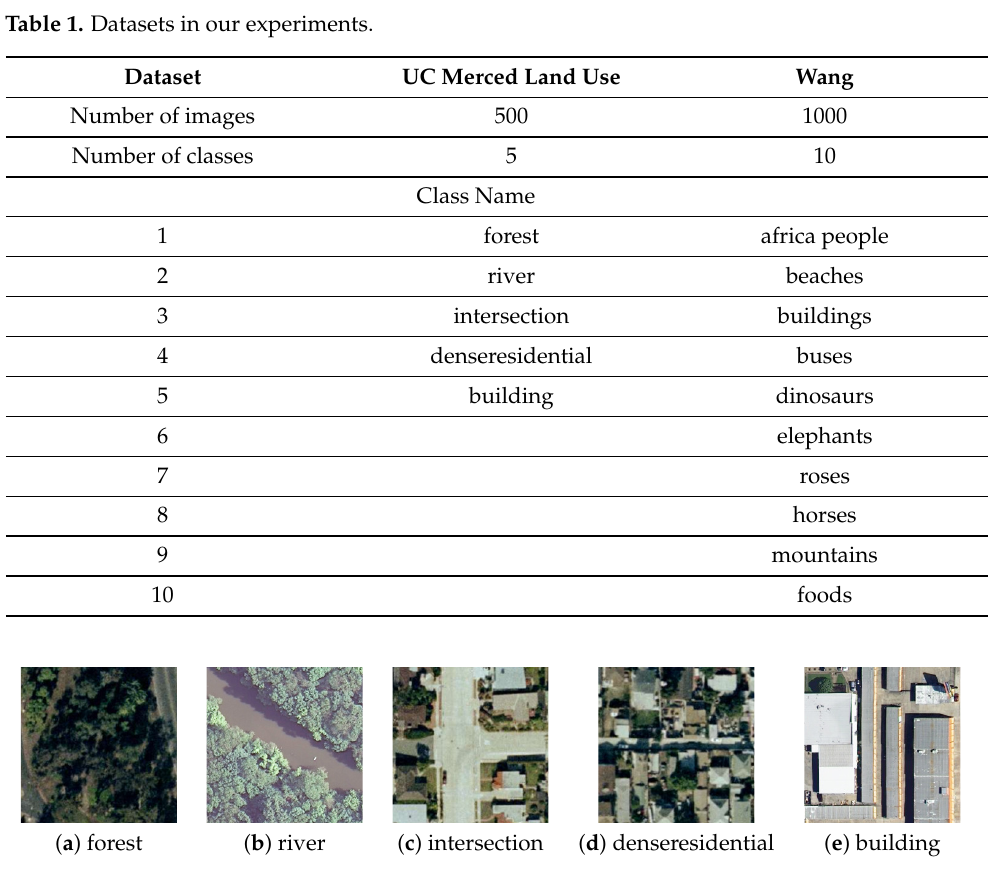
Figure 3. UC Merced land use